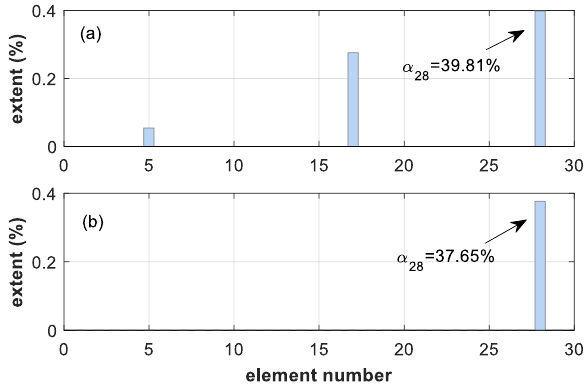
Figure 13. Damage identification results of damage case C at a 3% level of noise, with an iterative Tikhonov solution: ( a ) CMSE method; ( b ) RCMSE method.